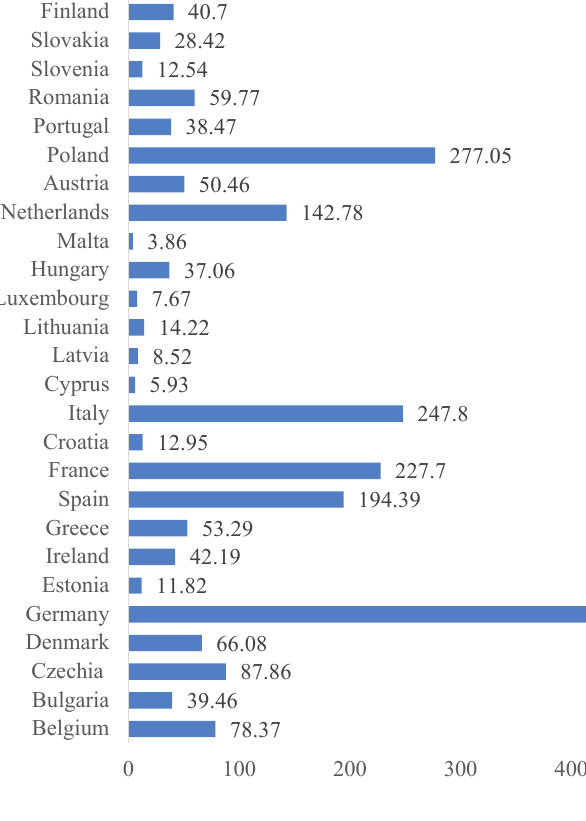
Fig. 1. CO 2 emissions in million metric tons in EU by country, year 2019